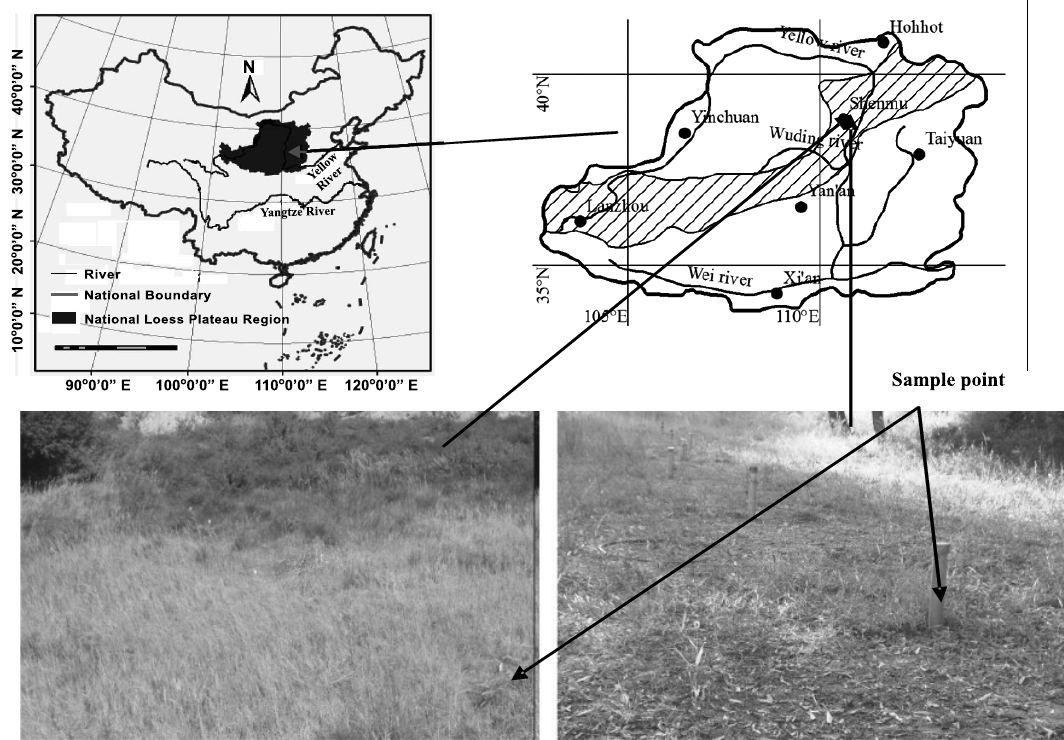
Figure 1. Study location on the Chinese Loess Plateau, with a general view of the deposited farmland soils and sample